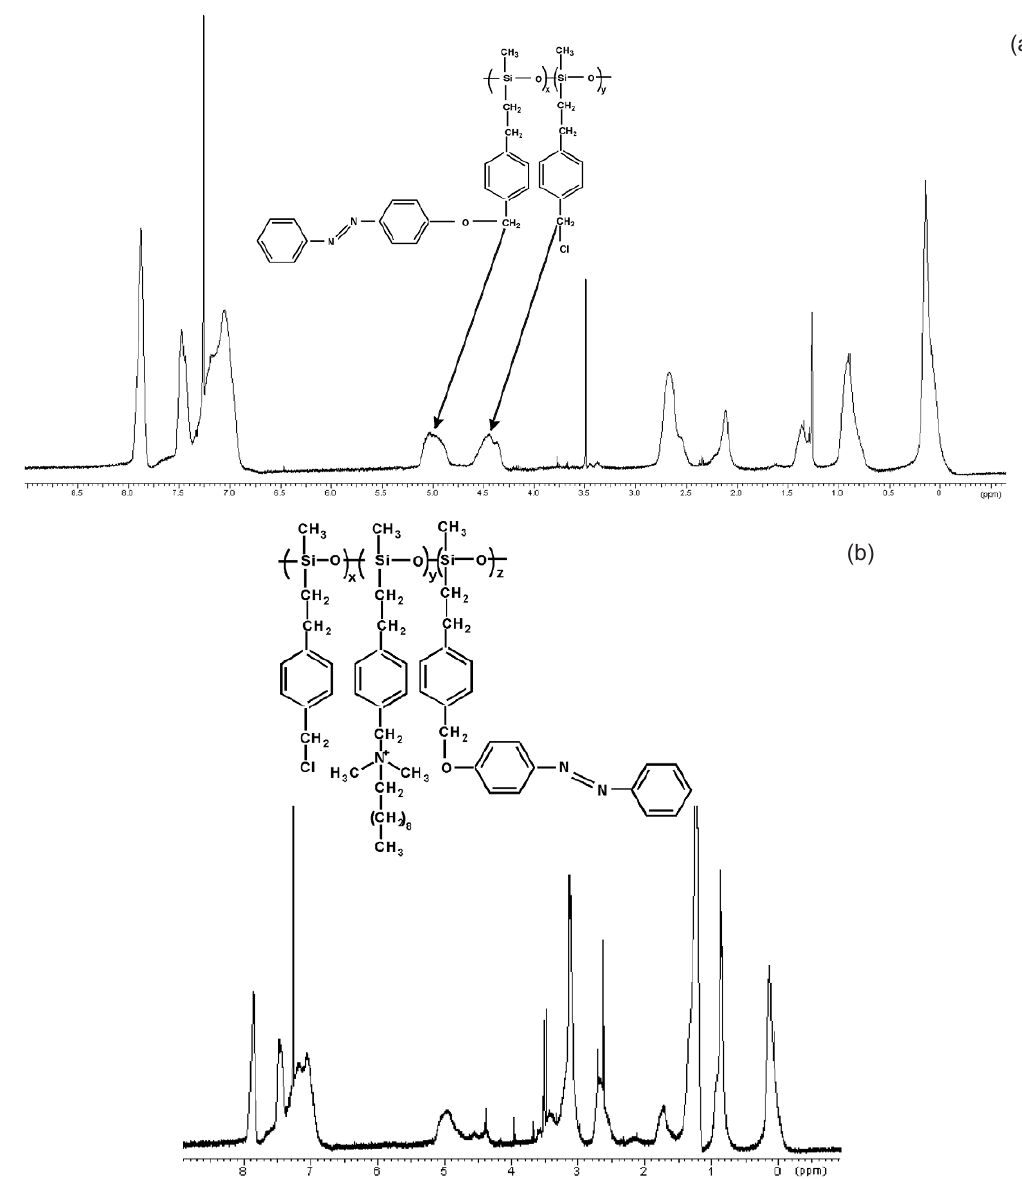
Figure 1. 1 H-NMR spectrum of Sample 2 after the first substitution step with azo groups (a) and the second substitution step with quaternary ammonium groups